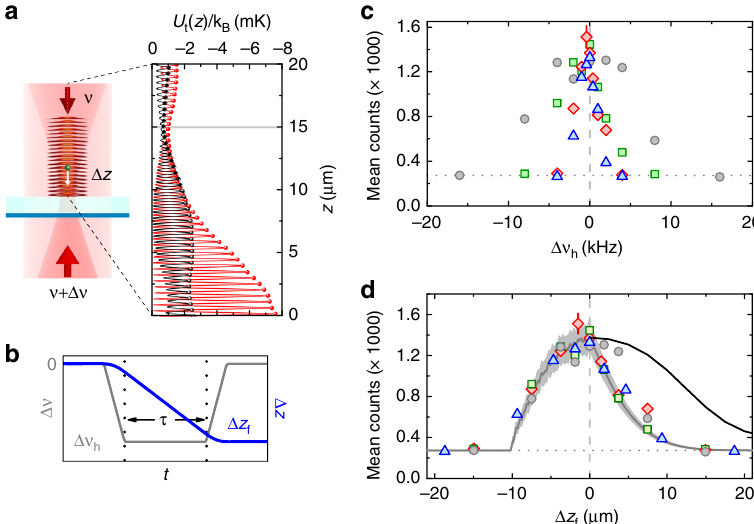
Fig. 3 Optical conveyor belt in a tweezer lattice. a Schematic and potential line-cuts U t ( z ) of the optical conveyor belt, shown at instances when the bottom dipole beam is in-phase (red curve) or out-of-phase (black curve) with respect to the tweezer beam surface re fl ection. The lattice site centers are marked by the color spheres. Note that the trap depth near the surface is large | U t | > k B × 2 mK until near the depth of fi eld z dof ≈ 15 μ m marked by the gray line. b Transport distance Δ z (blue curve) controlled by the frequency detuning Δ ν (gray curve) of the bottom dipole beam, which is linearly ramped to Δ ν h in 1 ms, held for a time τ , and then ramped back to zero. c Mean fl uorescence counts versus the detuning Δ ν h at various hold times τ = 1 (gray circles), 3 (green squares), 7 (red diamonds), and 9 (blue triangles) ms. d The same sets of measurements ( fi lled symbols) plotted against the fi nal distance Δ z f . Black solid line at Δ z f > 0 is a model considering count reduction only due to defocusing. Gray solid line is an empirical fi t and the shaded region takes into account the error of the mean; see text. The horizontal dotted lines mark the mean background counts. Error bar represents standard deviation of the